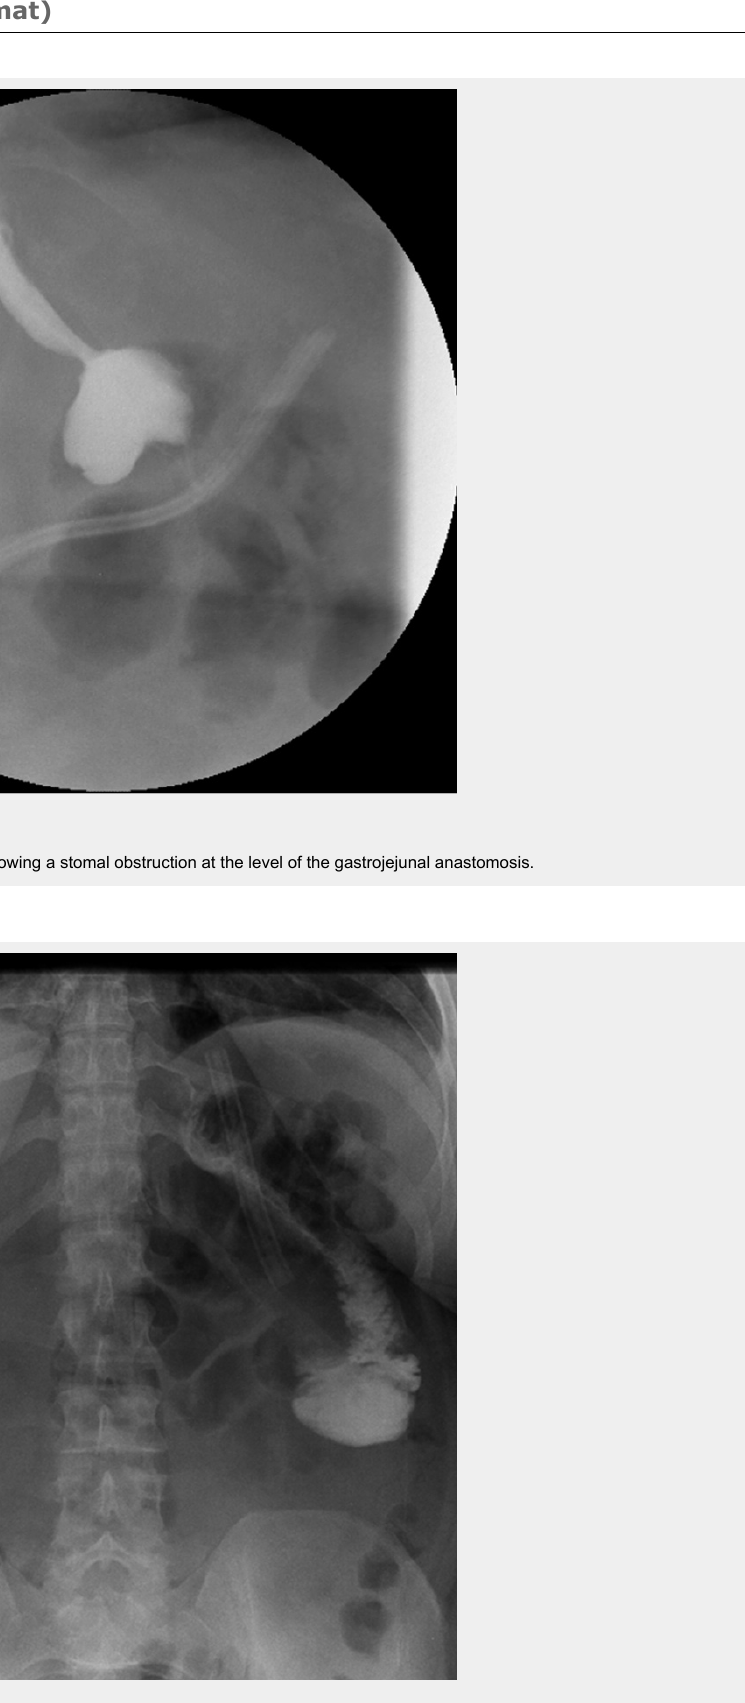
Figure 2 X-ray showing a stenosis at the level of the jejunojejunal